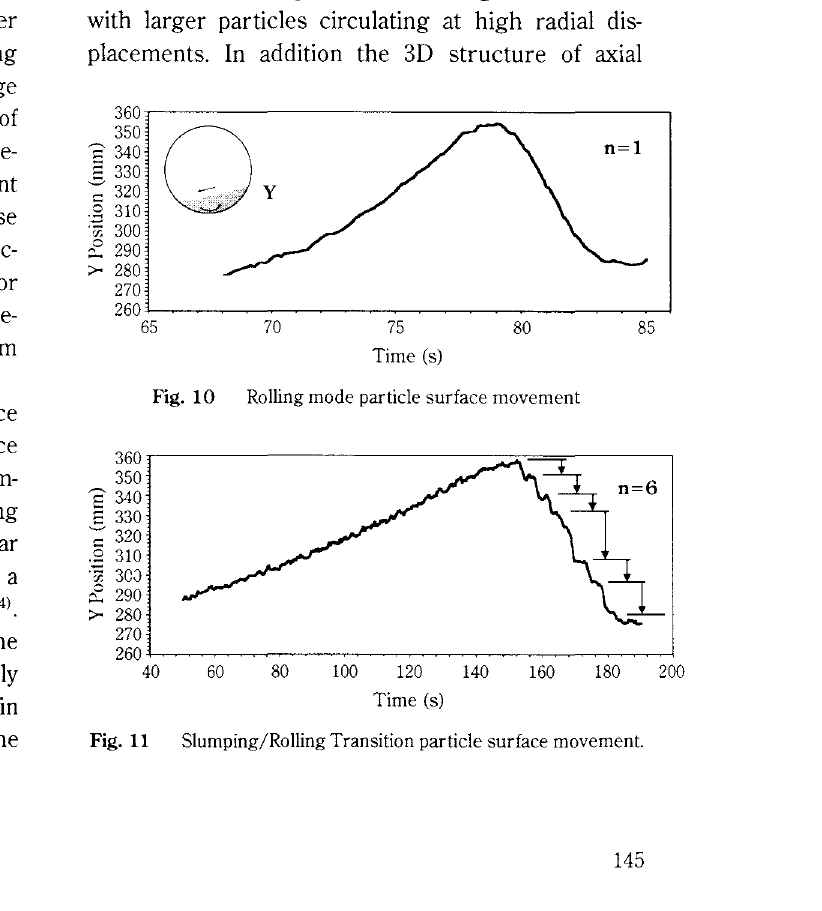
Slumping/Rolling Transition particle surface